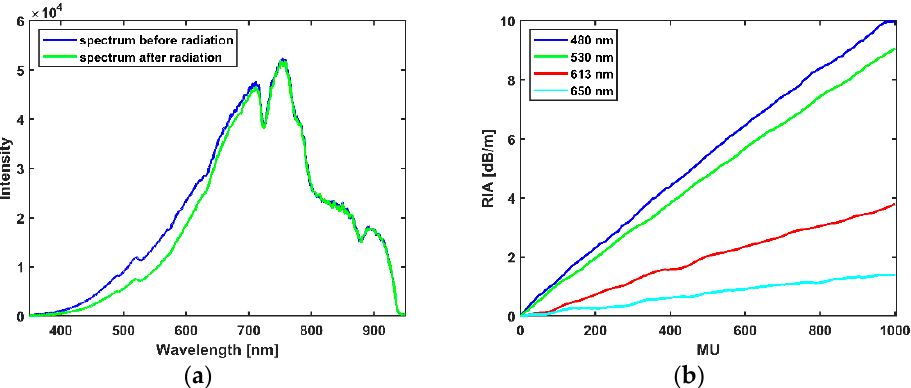
Figure 3. ( a ) Wavelength spectrum before and after radiation. ( b ) Dependence of the RIA on MU for 6 MV X-ray radiation. Table 1. Sensitivity of INO fibre at selected wavelengths for fibre irradiated with X-ray beam energy of 6 MV (dB/m/MU) and the estimated dose at 6 MV (dB/m/Gy) spectra.